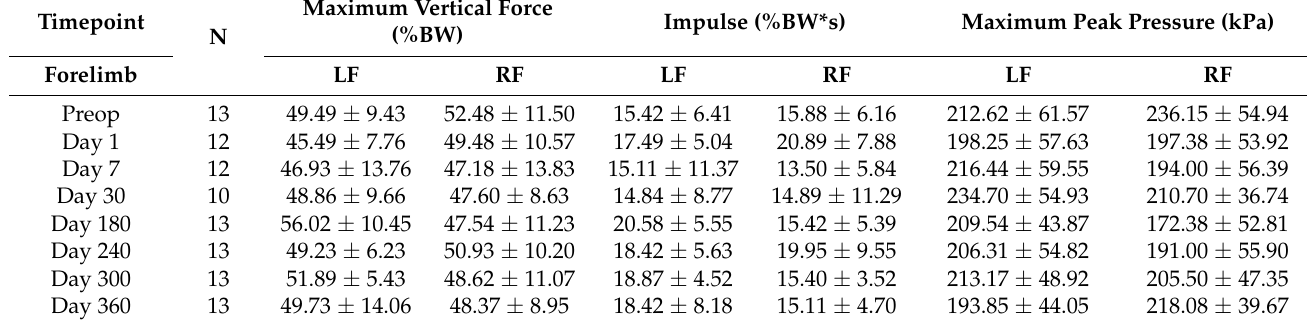
Table 2. Forelimb and hindlimb kinetics following right hindlimb tibial segmental defect and locking plate stabilization and right hindlimb cast immobilization. All values are presented as mean ± standard